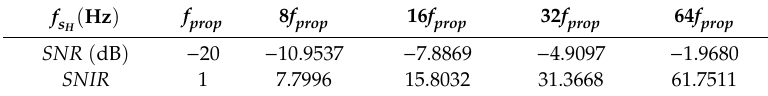
Table 3. The intensive sampling rectangular sparse reconstruction. The estimated parameters, SNR and SNIR are reported based on the synthetic MRS signal with U f prop = 24 f Larmor and SNR = − 20